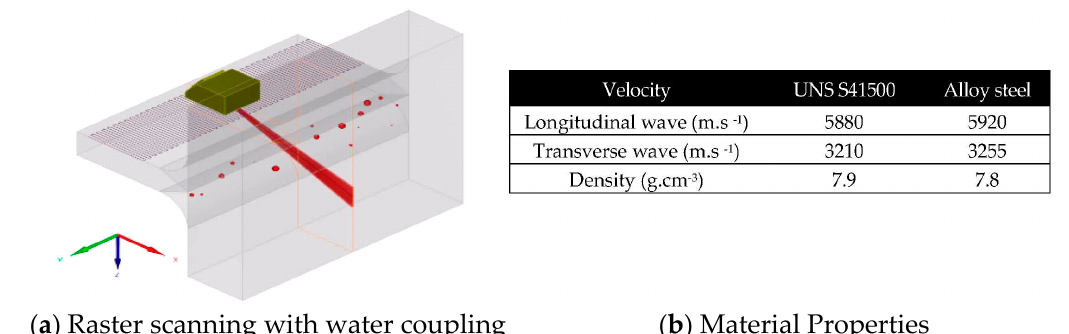
Figure 9. Scanning pattern and material properties